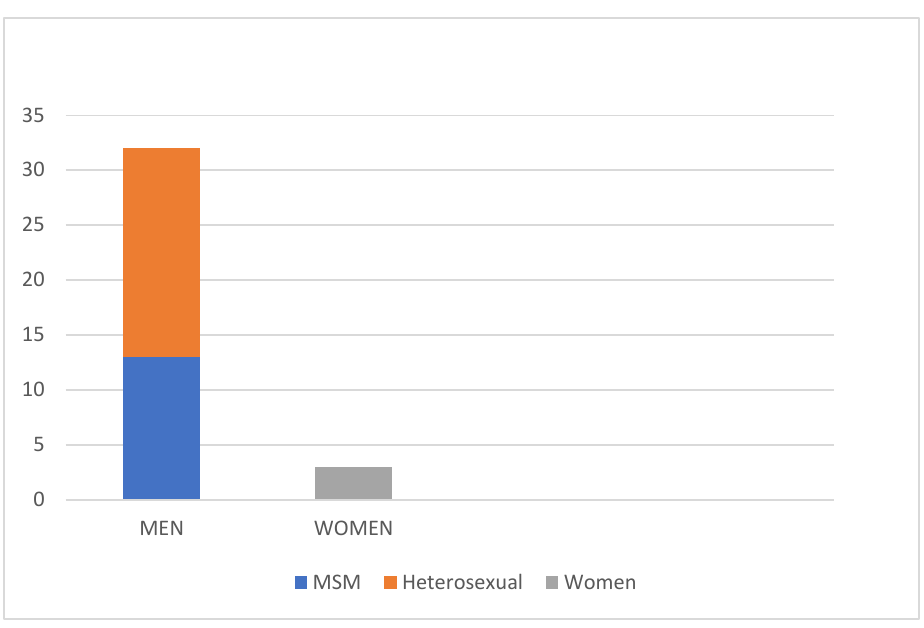
Figure 3. Distribution of the patients in our study based on sex. The vast majority being male (91.4%), 37% of which were MSM.